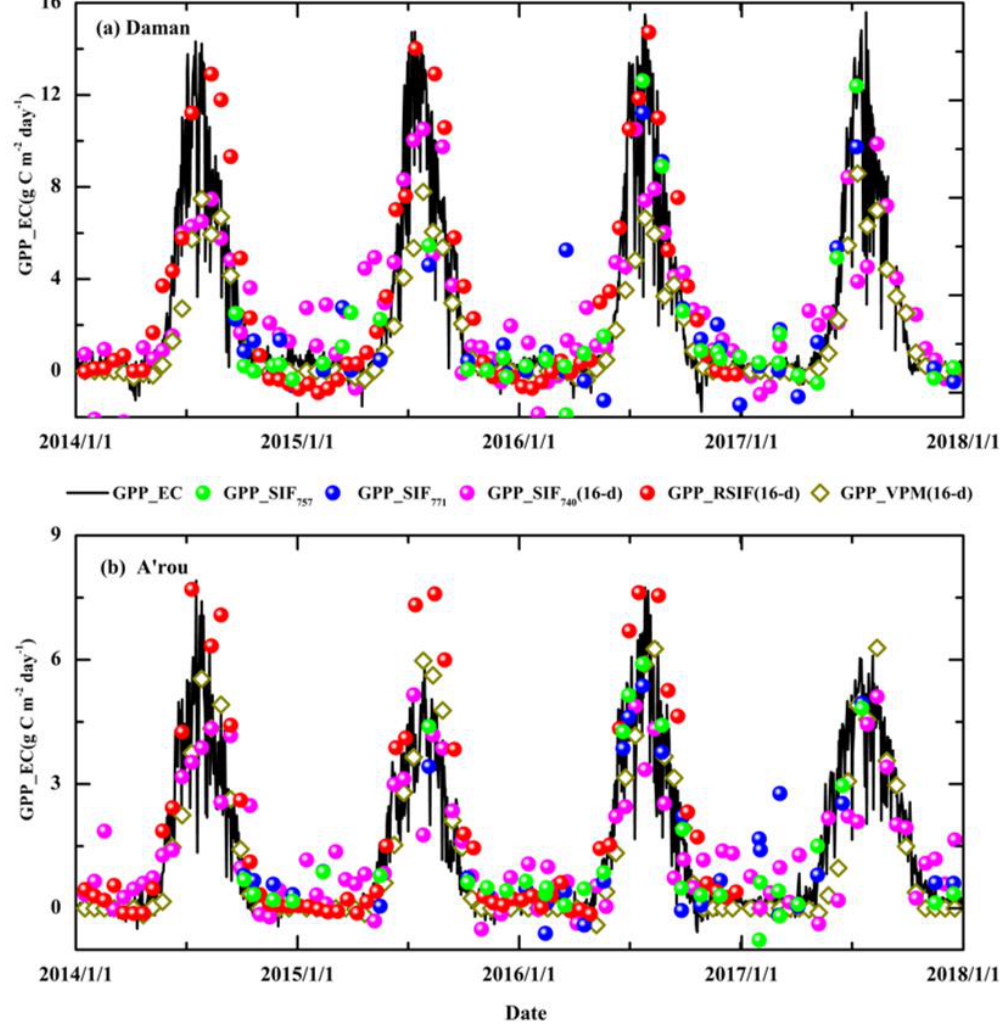
Figure 4. Validation of GPP estimates from SIF 757 , SIF 771 , SIF 740 , and VPM at the ( a ) Daman and ( b ) A’rou sites for the period 2014 – 2017.